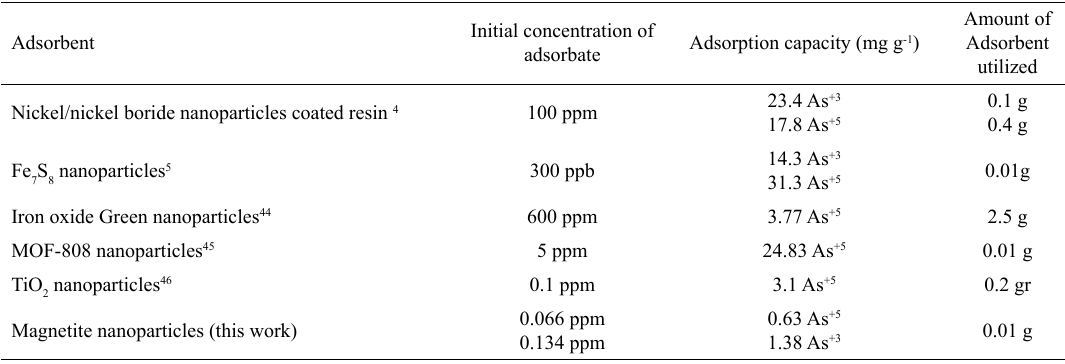
Table 4: Adsorption capacities of different types adsorbents, with different amounts of adsorbate and adsorbent. Adsorbent